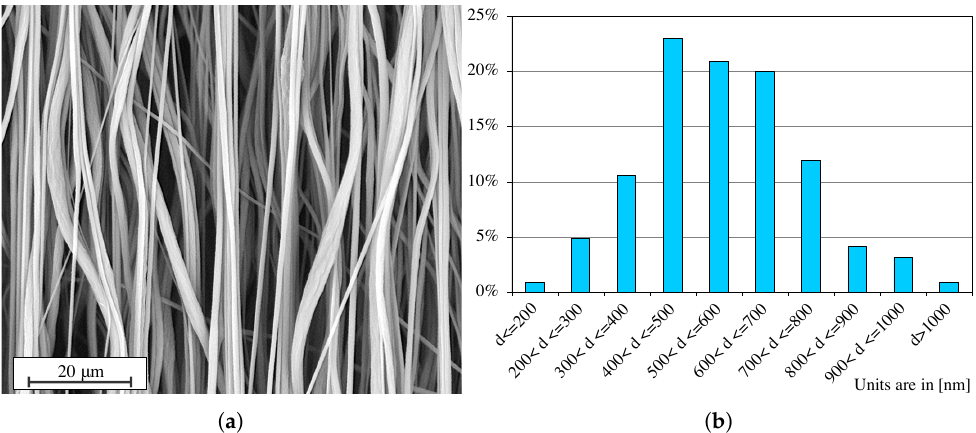
Figure 2. ( a ) SEM image of one specimen of the aligned nanofibers mat. ( b ) Histogram of the % distribution of the nanofibers’ diameters in three